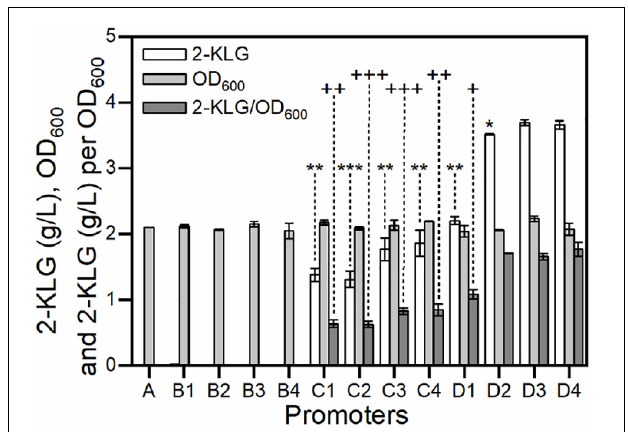
FIGURE 5 | Effect of over-expressing SDH by gradient promoters on the growth of G. oxydans and the yield of 2-KLG. The abscissa axis shows different promoters controlling the expression of SDH in G. oxydans . (A) negative control; (B1–B4) weak promoters P 1142 , P 0991 , P 1295 , and P 0327 ; (C1–C4) medium-strength promoters P 0647 , P 0205 , P 0804 , and P 1653 ; (D1–D4) strong promoters P 3022 , P 2038 , P 2057 , and P 2703 . The ordinate axis shows the titer of 2-KLG (g/L), OD 600 values and the titer of 2-KLG per OD 600 . * P < 0.05 2-KLG titer compared with D3 by two-tailed t test; ** P < 0.01 2-KLG titer compared with D3 by two-tailed t test; *** P < 0.001 2-KLG titer compared with D3 by two-tailed t test; D3 and D4 are not statistically significant in 2-KLG titer with p = 0.0667. + P < 0.05 2-KLG titer per OD 600 compared with D3 by two-tailed t test; ++ P < 0.01 2-KLG titer per OD 600 compared with D3 by two-tailed t test; +++ P < 0.001 2-KLG titer per OD 600 compared with D3 by two-tailed t test; D2 and D3 are not statistically significant in 2-KLG titer per OD 600 with p = 0.227; D4 and D3 are not statistically significant in 2-KLG titer per OD 600 with p =